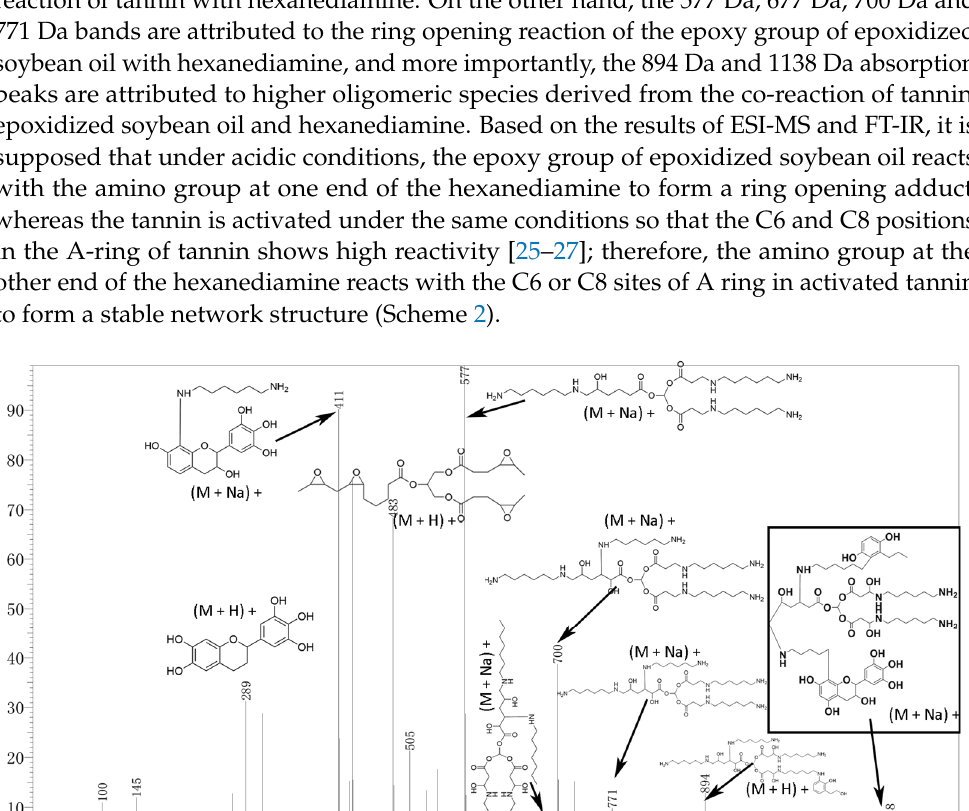
Figure 2. ESI-MS spectra of the tannin-epoxidized soybean oil-hexanediamine (TEH) resin.